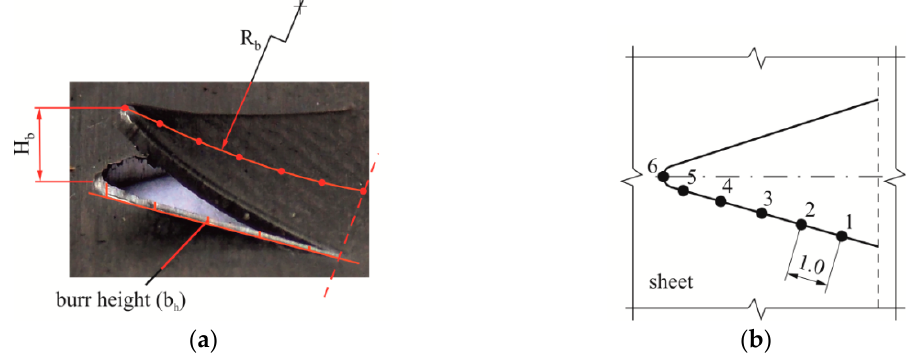
Figure 8. The idea of burr measurement: ( a ) System of base surfaces and ( b ) measurement scheme.